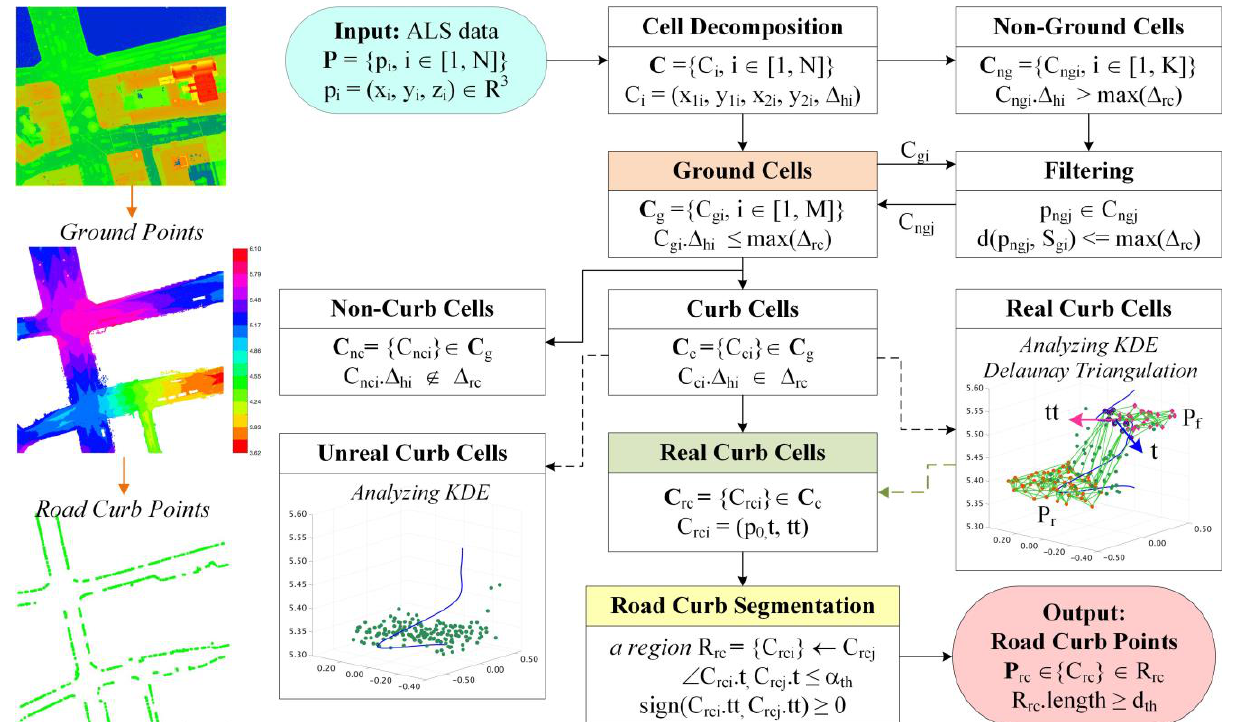
Figure 1. Workflow of the proposed